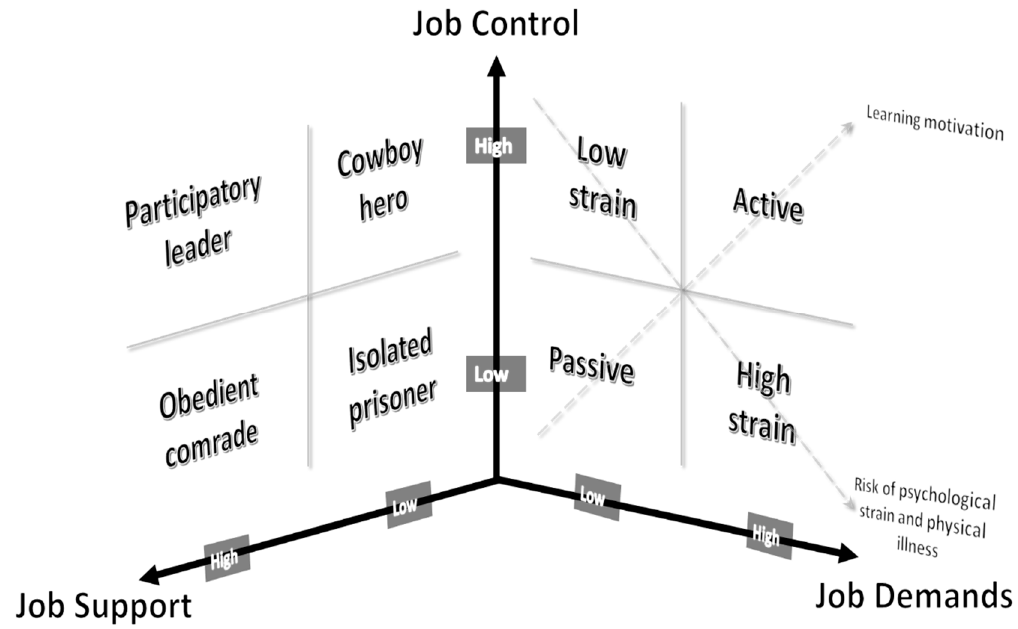
Figure 1. The three-dimensional Job Demand-Control-Support (JDCS) model of psychosocial work environment (adapted from Karasek and Theorell, 1990, p. 70).